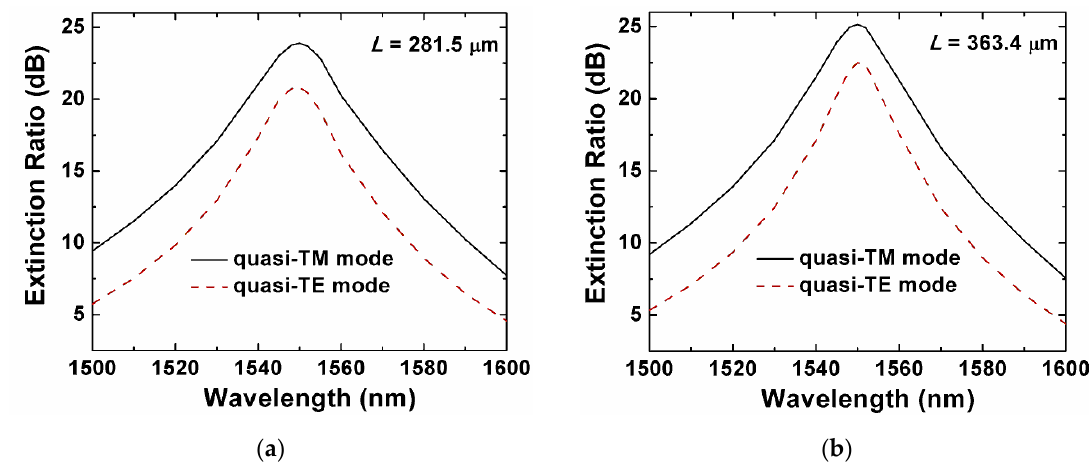
Figure 7. Extinction ratio of the quasi-TM mode at the bar port and the quasi-TE mode at the cross port of the proposed Si 3 N 4 horizontal slot ( a ) and strip ( b ) waveguide PBS.